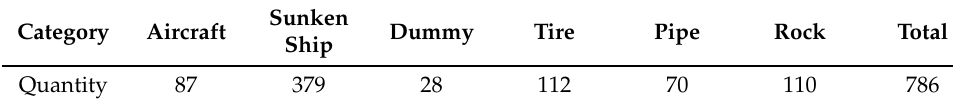
Figure 2. Sonar image in the dataset. Table 1. The quantity of samples in each